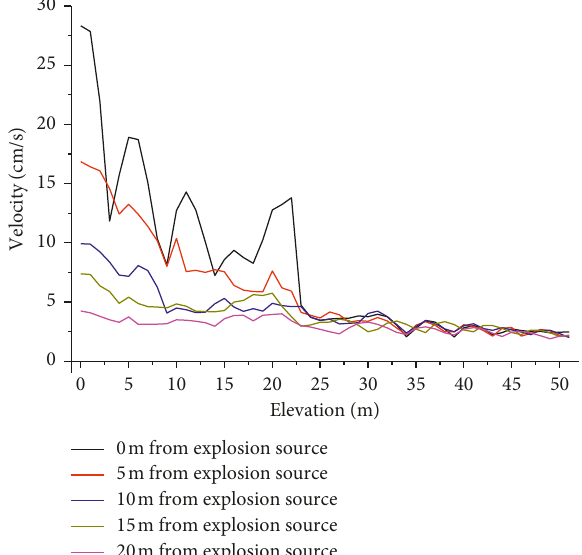
Figure 9: Vibration velocity curve in the elevation direction with different horizontal distances.